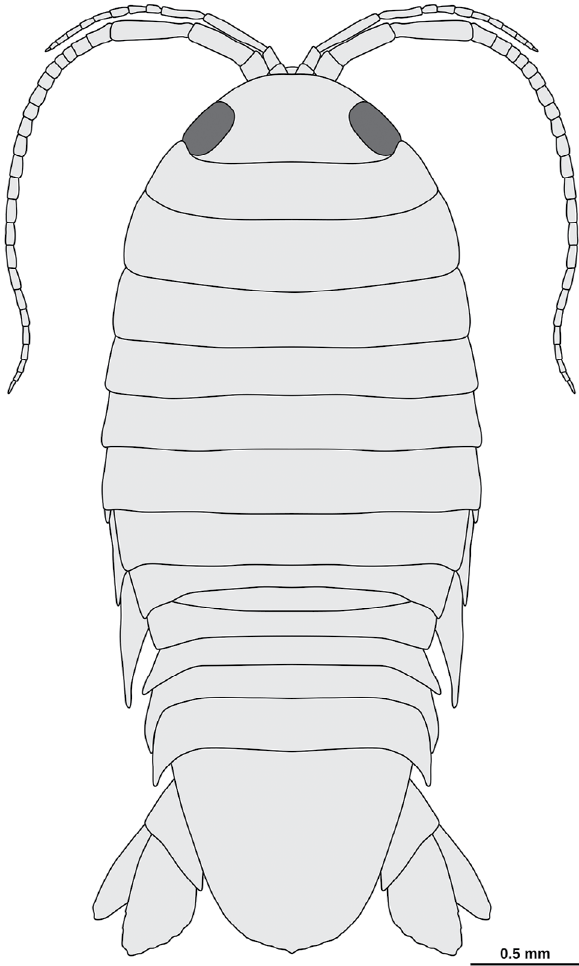
Figure 6. Drawing of the holotype of Electrolana madelineae sp. nov. (NHMW 2017/0052/0001), dorsal view, composite of microscopic images and micro-CT scan